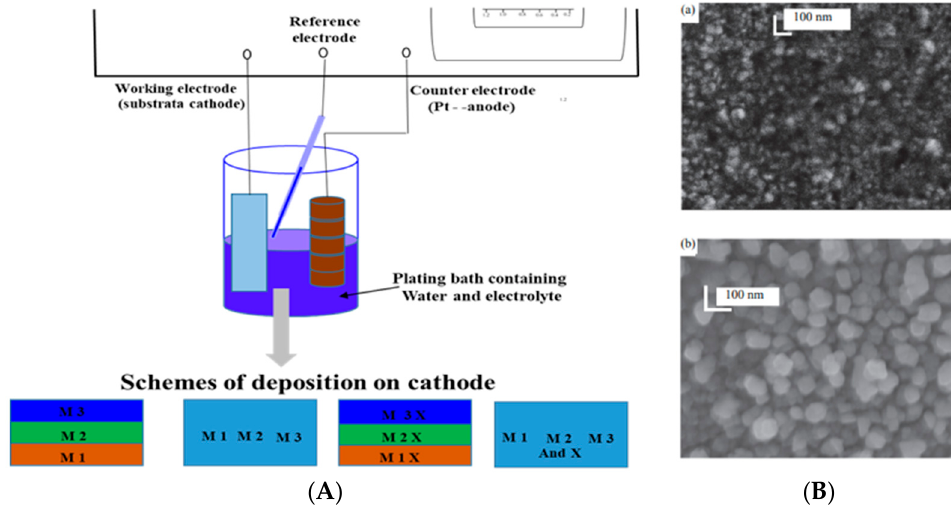
Figure 13. ( A ) Schematic diagram of the Electrochemical Deposition Process , ( B ) SEM images of niobium oxide films derived from the cathodic deposition of an acidic (pH 2.5) solution of niobium peroxo complexes at potentials of (a) 200, (b) − 200 [129]. Reprinted with permission from [129]. Copyright 2013 Springer.